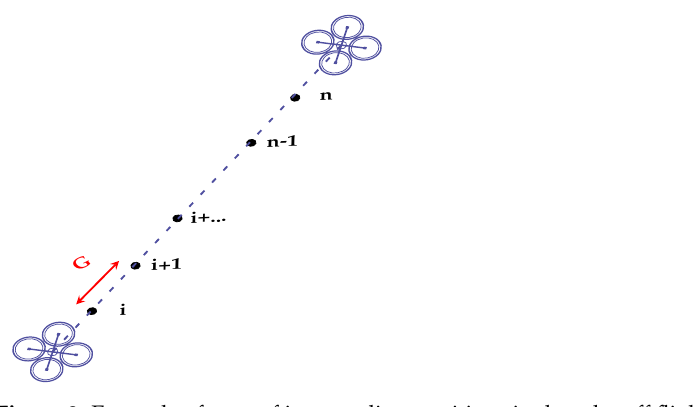
Figure 3. Example of a set of intermediate positions in the take-off flight